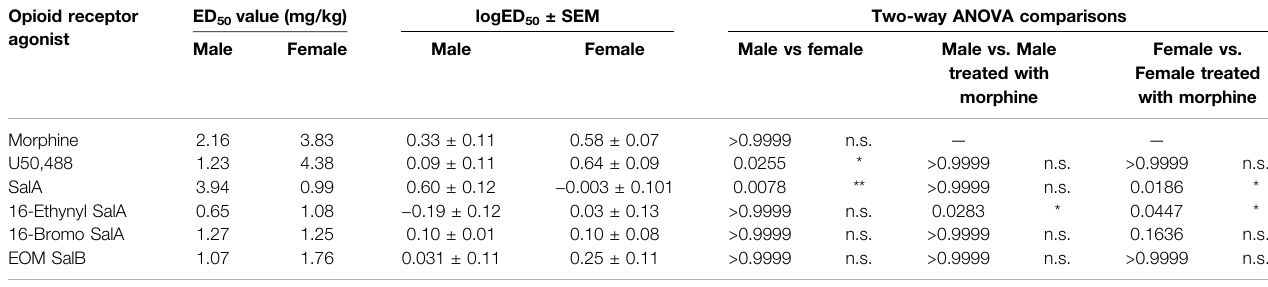
TABLE 1 | Dose-response effects of the KOR agonists in female and male mice with established paclitaxel-induced mechanical allodynia. The potency (ED 50 ) of the opioid receptor agonists were measured in mice of both sexes. U50,488 had more potent effects in males compared to females, whereas SalA was more potent in females. When the KOR treatments for each sex were compared to morphine, 16-Ethynyl SalA was signi fi cantly more potent in males and females. SalA was more potent than morphine in females only. Non-linear regression analysis. Two-way ANOVA with Bonferroni post-tests. n = 6 – 7. n.s. = not signi fi cant, * p < 0.05, ** p < 0.01. Opioid receptor agonist